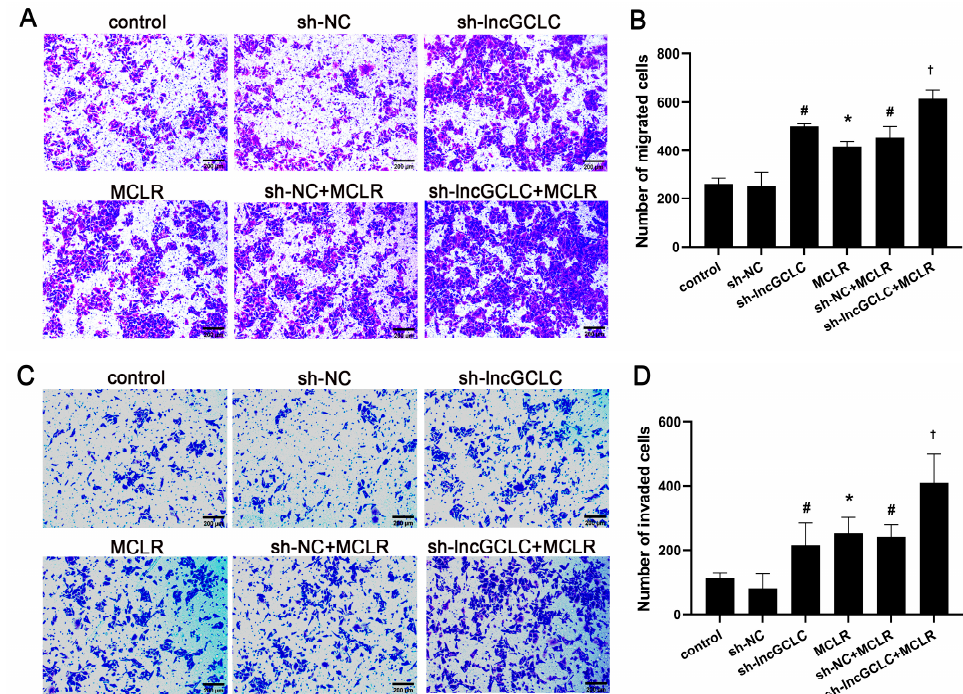
Figure 3. Knockdown of lncGCLC promoted the migration and invasion of MCLR-treated WRL68 cells. Vector- or sh-lncGCLC-transfected cells were treated with or without 10 μ g/L of MCLR for 25 passages. ( A ) Representative images of a cell migration assay (100×), scale bar = 200 μ m. ( B ) Quantification of cell migration. ( C ) Representative images of a cell invasion assay (Original magnification ×100, scale bar = 200 μ m). ( D ) Quantification of cell invasion. Data are presented as the means ± SD of three independent experiments in each group. * p < 0.05 compared with the control group; # p < 0.05 compared with the sh-NC group; † p < 0.05 compared with the sh-NC + MCLR group.